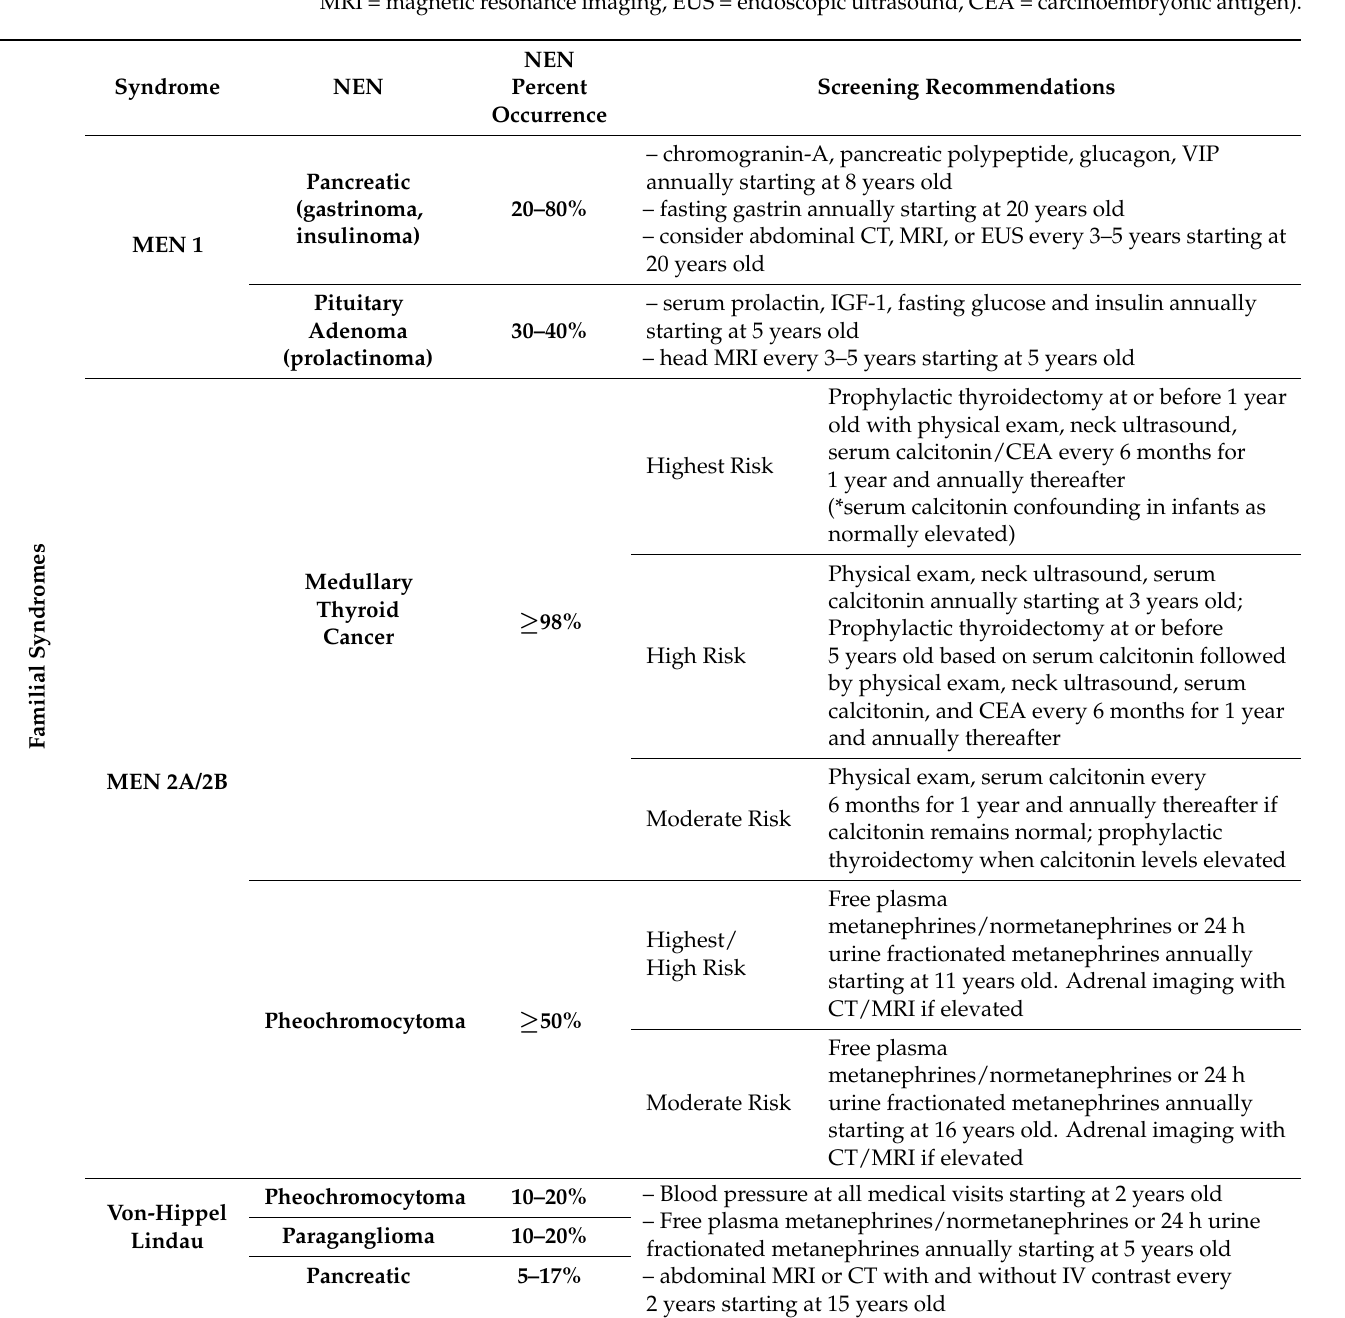
Table 2. Screening recommendations in children with known familial syndromes at increased risk for developing different NENs. Modified from the 2015 American Thyroid Association guidelines and the 2021 NCCN Neuroendocrine and Adrenal Tumors guidelines [2,60]. (CT = computed